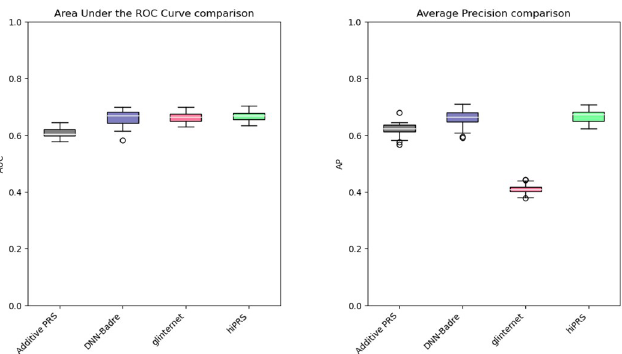
Fig 7. Results and comparisons for a real biological setting. AUC (left) and AP (right) performance distributions of 30 independent trials, sampled according to a real biological mechanism where SNPs regulate factors associated to atrial fibrillation. In grey, a traditional PRS with additive effects only; in violet the ML based algorithm, DNN-Badre; in pink glinternet (31 logistic terms); in green hi PRS ( K = 13).